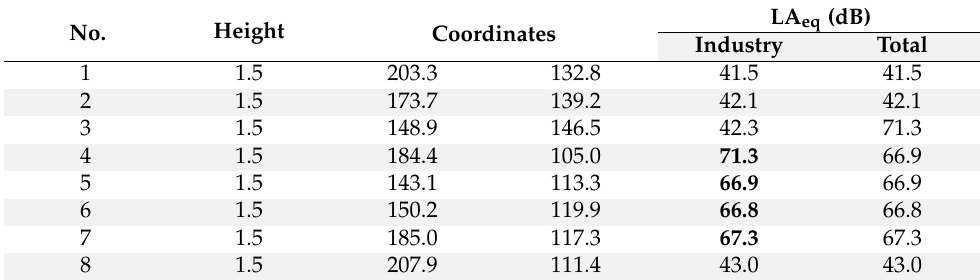
Figure 15. Colour map of isophone bands after considering acoustically significant elements (without construction site fencing or a solid gate) for the concreting of foundations in the investigated area, with the position of machines inside the construction site. Table 18. Table of points from the calculation of measured points for pile-driving work without construction site fencing or a solid gate in the investigated area, with the position of machines inside the construction site.